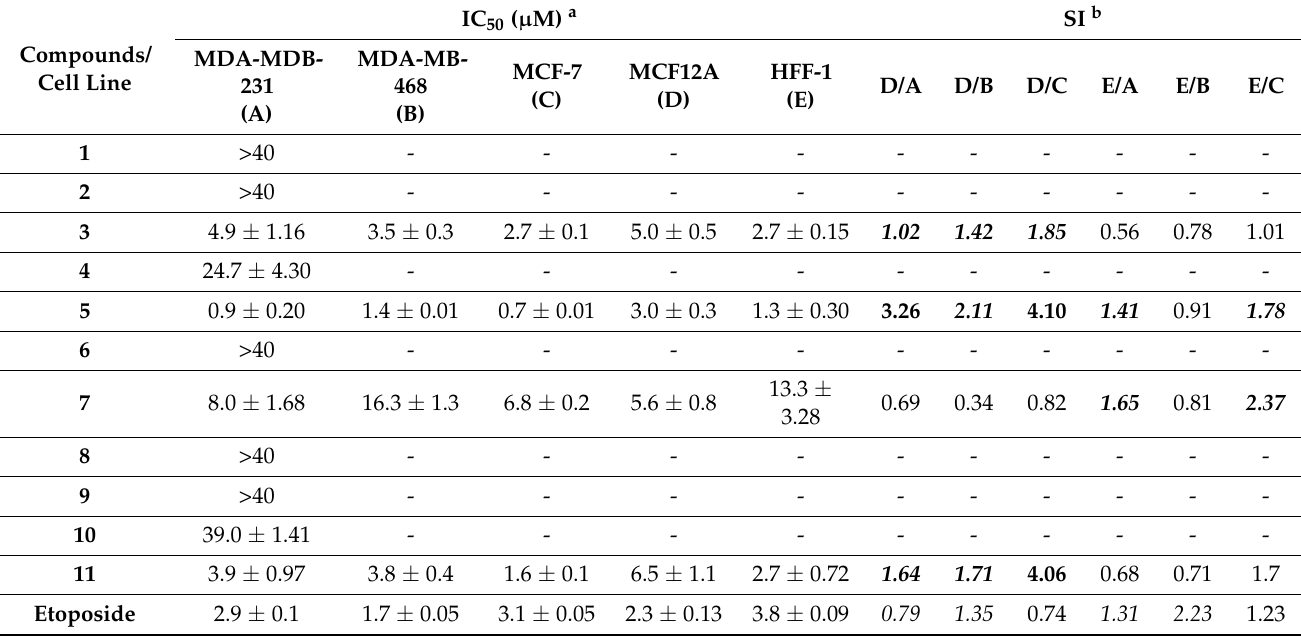
Table 1. Effect of compounds 1 – 11 on the growth in a panel of human breast cancer (triple negative MDA-MB-231 and MDA-MB-466 cell lines, and MCF-7 cells) and non-tumorigenic fibroblast (HFF-1 and breast (MCF12A)) cell